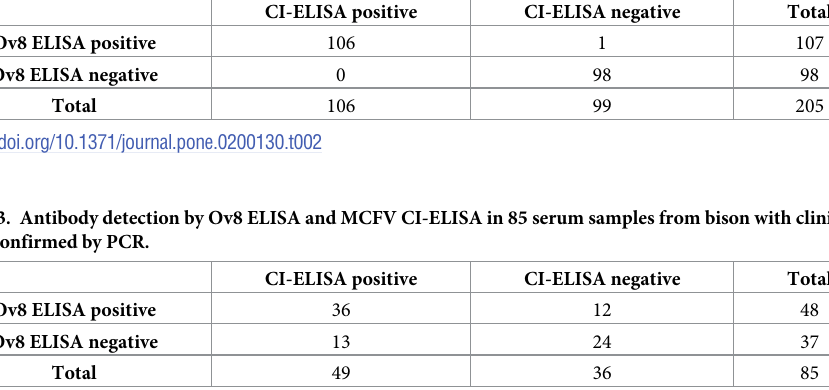
Table 2. Results for sheep sera as tested by the MCFV CI-ELISA and the Ov8 ELISA. CI-ELISA positive CI-ELISA negative Total Ov8 ELISA positive 106 1 107 Ov8 ELISA negative 0 98 98 Total 106 99 205